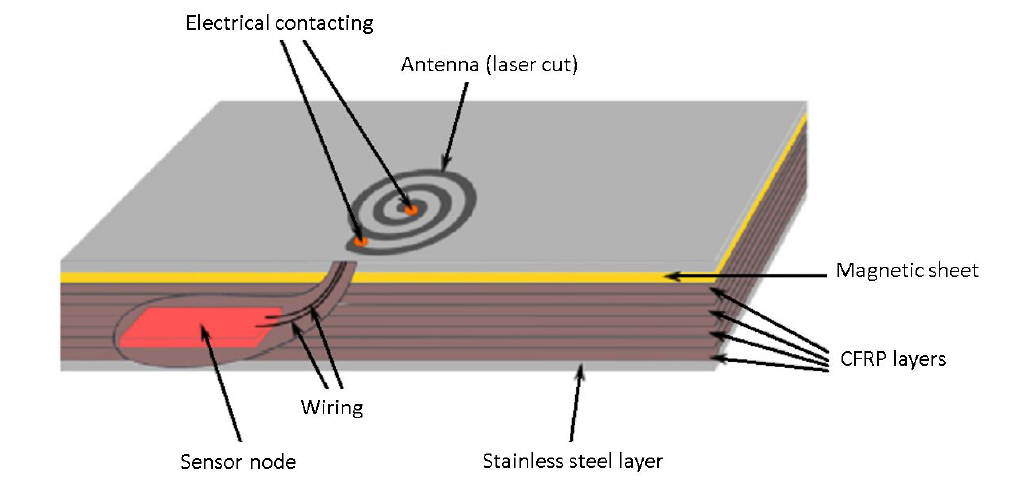
Figure 1. Concept of FML SHM system with laser-structured